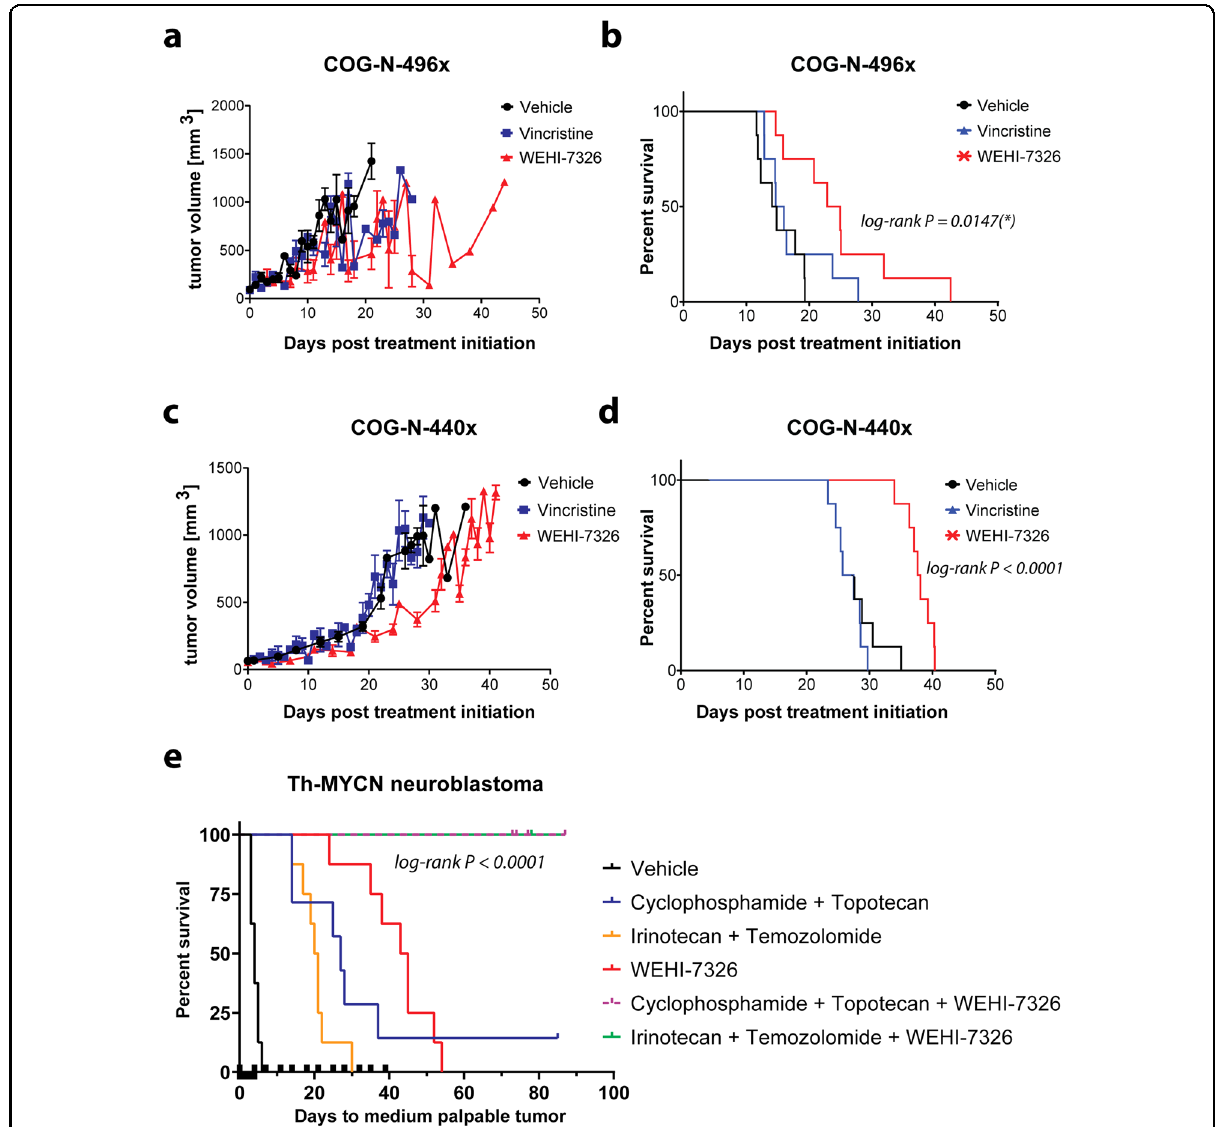
Fig. 7 WEHI-7326 prolongs survival in mouse models of high-risk neuroblastoma and leads to complete tumor regression when used in combination with standard-of-care relapse therapies. Tumor growth curve ( a ) and Kaplan – Meier survival plot ( b ) of relapsed HR NB PDX model COG-N-496x treated with either vincristine (0.5 mg/kg, i.p.; once) or WEHI-7326 (20 mg/kg, i.v.; twice a week). p (vincristine) = 0.3741 (ns), p(WEHI- 7326) = 0.0023 (**) compared to vehicle control; p-values obtained through Log-rank (Mantel-Cox) test, n = 8 mice. Tumor growth curve ( c ) and Kaplan – Meier survival plot ( d ) of refractory HR NB PDX COG-N-440x. p (vincristine) = 0.3602 (ns), p (WEHI-7326) <0.0001 (****) compared to vehicle control; p -values obtained through Log-rank (Mantel-Cox) test, n = 8 mice. e Kaplan – Meier survival plot of Th-MYCN transgenic model: spontaneous neuroblastoma driven by targeted expression of human MYCN in the developing mouse neural crest under control of the rat tyrosine hydroxylase (TH) promoter. Tumor growth was assessed by abdominal palpation and mice were euthanized at a medium palpable tumor of 1 cm 3 . Treatment schedules were vehicle control (saline); WEHI-7326 (20 mg/kg; twice weekly for 5 weeks; i.v.); cyclophosphamide (10 mg/kg, daily i.p.); topotecan (0.5mg/kg, daily IP); irinotecan (2 mg/kg, daily, i.p.) and temozolomide (5 mg/kg, daily, i.p.). Mice that are surviving on this graph past 100 day